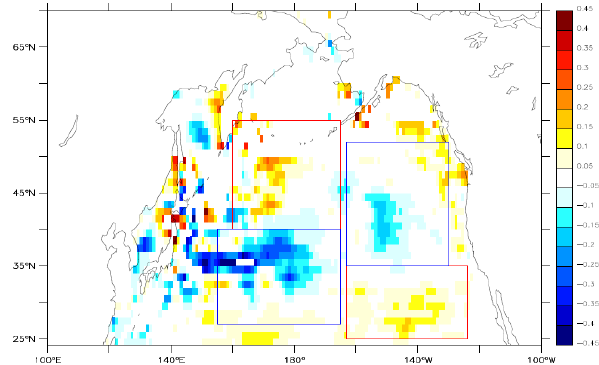
Figure 13: Regressed net air-to-sea CO 2 flux anomalies (negative represents CO 2 flux from atmosphere 3 Fig. 13. Regressed net air-to-sea CO 2 flux anomalies (negative to ocean and vice versa, mol m −2 yr −1 ) over PDO. 4 represents CO 2 flux from atmosphere to ocean and vice versa, molm − 2 yr − 1 ) over PDO.